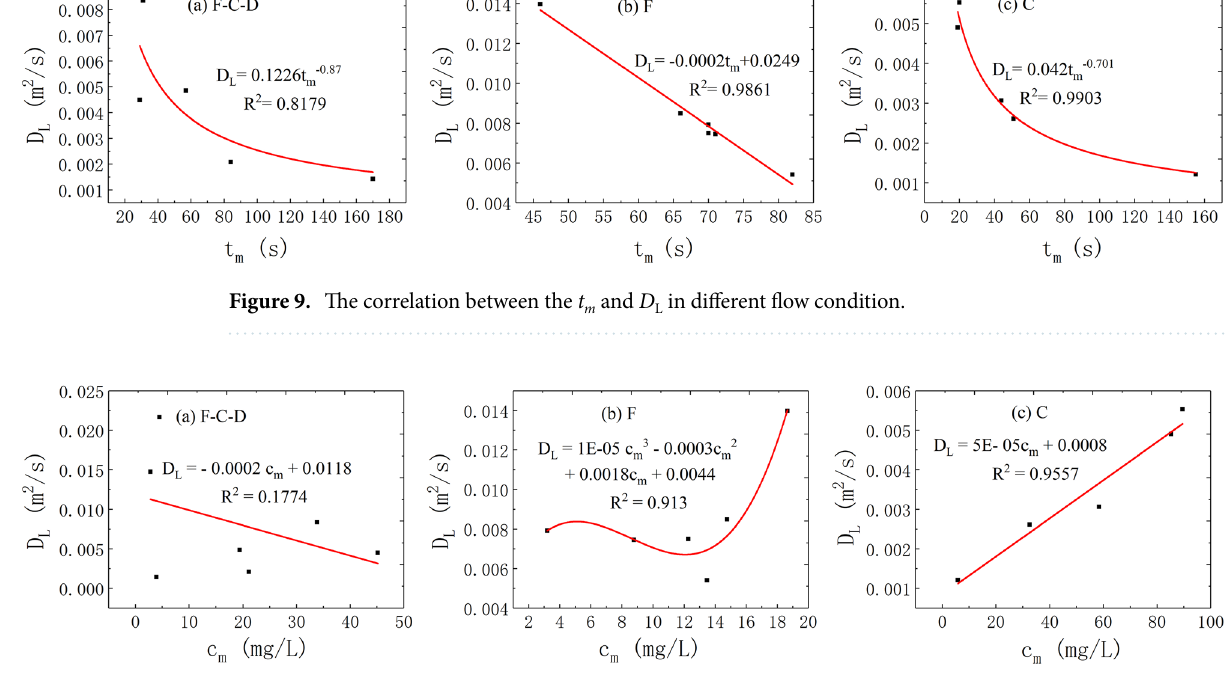
Figure 10. The correlation between the c m and D L in different flow